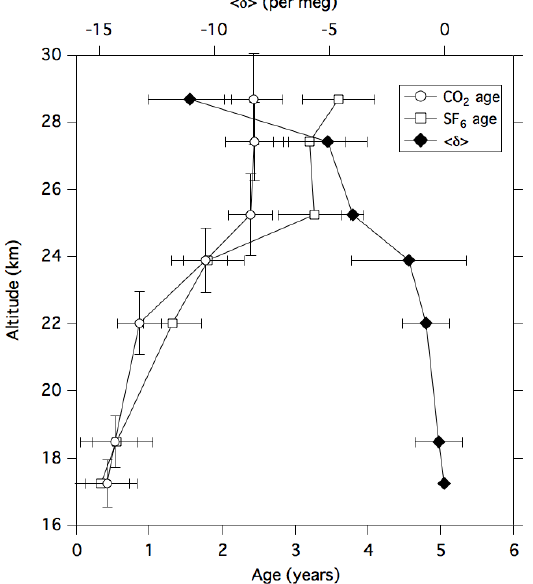
Figure 6. Vertical profiles of the CO 2 and SF 6 ages and the < δ > value over Biak, Indonesia on 22–28 February 2015. The < δ > value represents an average of δ 15 N of N 2 , ( δ 18 O of O 2 )/ 2, and δ (Ar / N 2 )/ 12 (cf. text). Vertical error bars of CO 2 age repre- sent vertical ranges of air